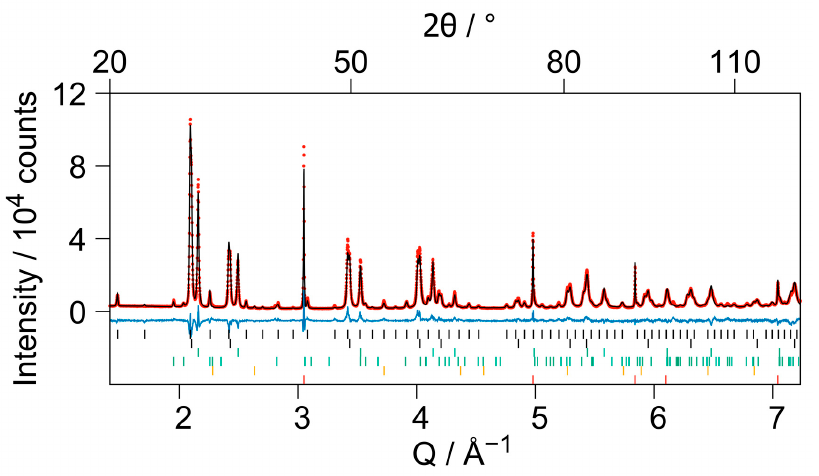
Figure A2. Rietveld refinement of the crystal structure of orthorhombic LuHO obtained from LuH 3 and CaO on the basis of X-ray diffraction data at ambient temperature ( λ : Cu- K α 1 ). R wp = 10.1%, GoF = 7.3. Bragg markers denote from top to bottom: LuHO Pnma (31.3(4) wt%, R I = 7.9%, a = 7.3493(7) Å, b = 3.6747(4) Å, c = 5.1985(3) Å), LuHO F 43 m (35.8(4) wt%, a = 5.17312(11) Å), LuH 2 Fm 3 m (27.32(17) wt%, a = 5.03582(8) Å), LuH 3 P 3 c 1 (3.12(6) wt%, a = 6.1689(6) Å, c = 6.4317(10) Å), CaO Fm 3 m (2.4(3) wt%, a = 4.7687(15) Å). Red dots: measurement meas , black curve: calculation calc , blue curve: difference meas-calc